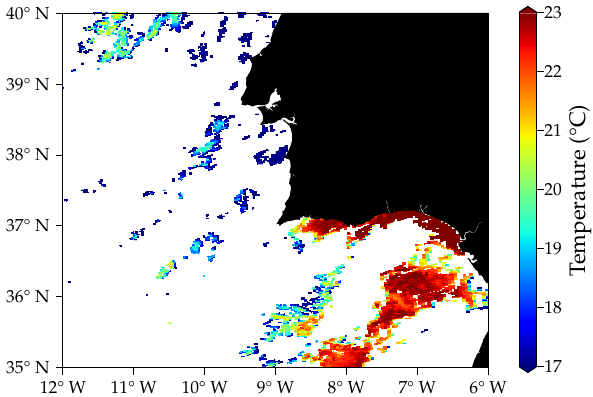
Figure 1. Example of a bad quality satellite